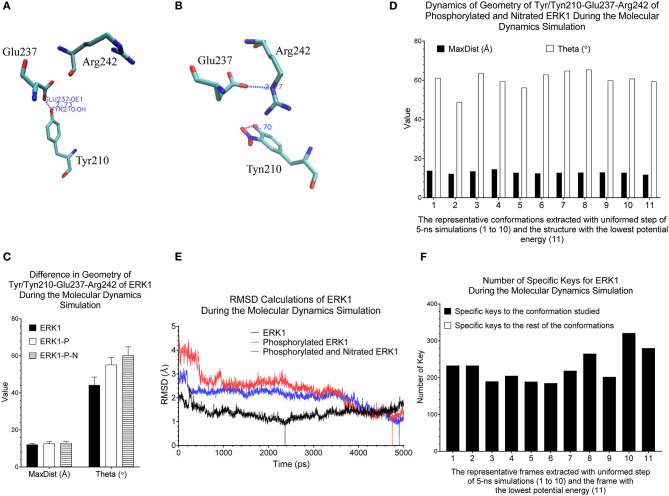
Our method can detect fine structural changes of ERK1 due to the post-translational modifications. (A) Three amino acids, Tyr210, Glu237, and Arg242, of the crystal structure (PDB ID: 2ZOQ) of ERK1 are shown. The hydrogen bond between Tyr210 and Glu237 is labeled; (B) The frame of ERK1-P-N having the lowest potential energy was extracted from 5-ns MD simulation. The intra-residue hydrogen bond between Tyn210 and Glu237, and the inter-residue hydrogen bind between Glu237 and Arg242 are labeled; (C) The MaxDist and Theta of the triangle of Tyr/Tyn/210-Glu237-Arg242 of ERK1, ERK1-P and ERK1-P-N were calculated. Mean ± SD are indicated; (D) Ten frames from the uniformed steps of 5-ns simulations were extracted and they are named as frames 1–10. The frame of ERK1-P-N with the lowest potential energy is labeled as frame 11; (E) RMSD values of ERK1, ERK1-P, and ERK1-P-N were calculated using their corresponding frames with the lowest potential energy, during 5-ns MD simulations, as the reference, (F) The numbers of specific keys exclusively belonging to each of the 11 frames (1–11) of ERK1-P-N were calculated and are presented. The numbers of specific keys exclusively belonging to all frames, except for the one frame indicated, were also calculated and are presented. The frame with the lowest potential energy is labeled as 11.